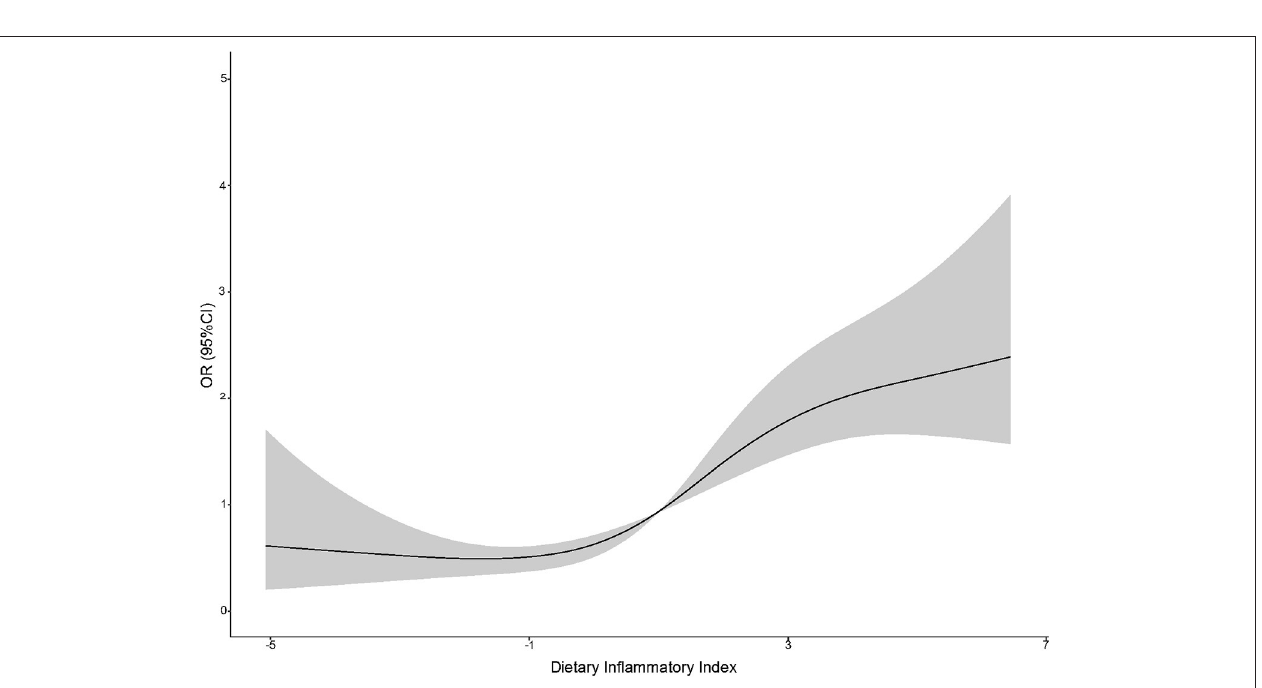
FIGURE 2 | A restricted cubic spline curve was used to fit the relationship between DII and the risk of depression (the three nodes are located at the 25th, 50th, and 75th percentiles). Risk estimates were adjusted for age, sex, physical activity, education level, smoking status, drinking status, daily energy intake, and employment status. Reference value for ORs: median score (1.80); the solid black line represents the OR and the shaded part the lower and upper 95% CI; P Overall < 0.001; P Nonlinear =